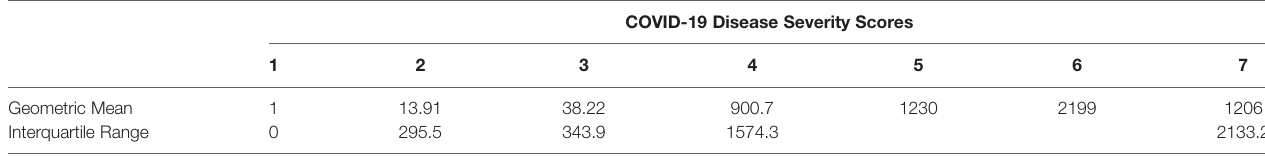
TABLE 4 | COVID-19 disease severity scores geometric means and interquartile ranges expressed in International Units